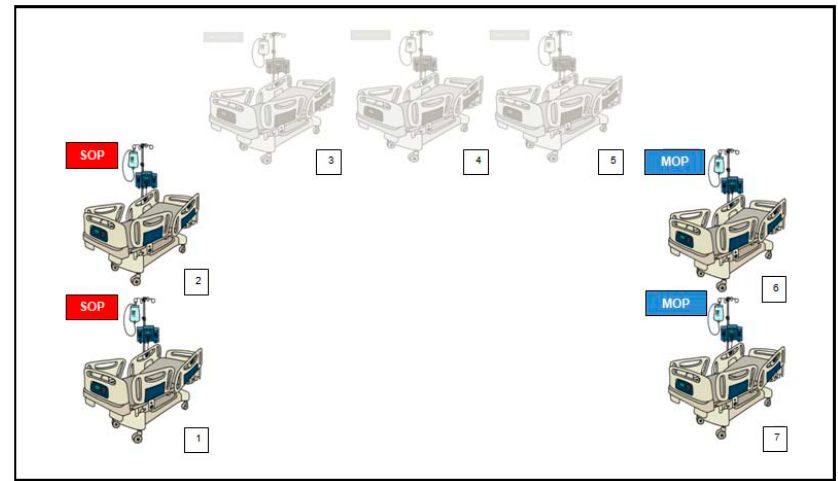
Figure 1. Patient units selected for the study (2 in each opposite side of the open-space, functionally separated) and cleaning and disinfection procedures applied in each units (SOP: Standard Operative Protocol, MOP: Modified Operative Protocol).